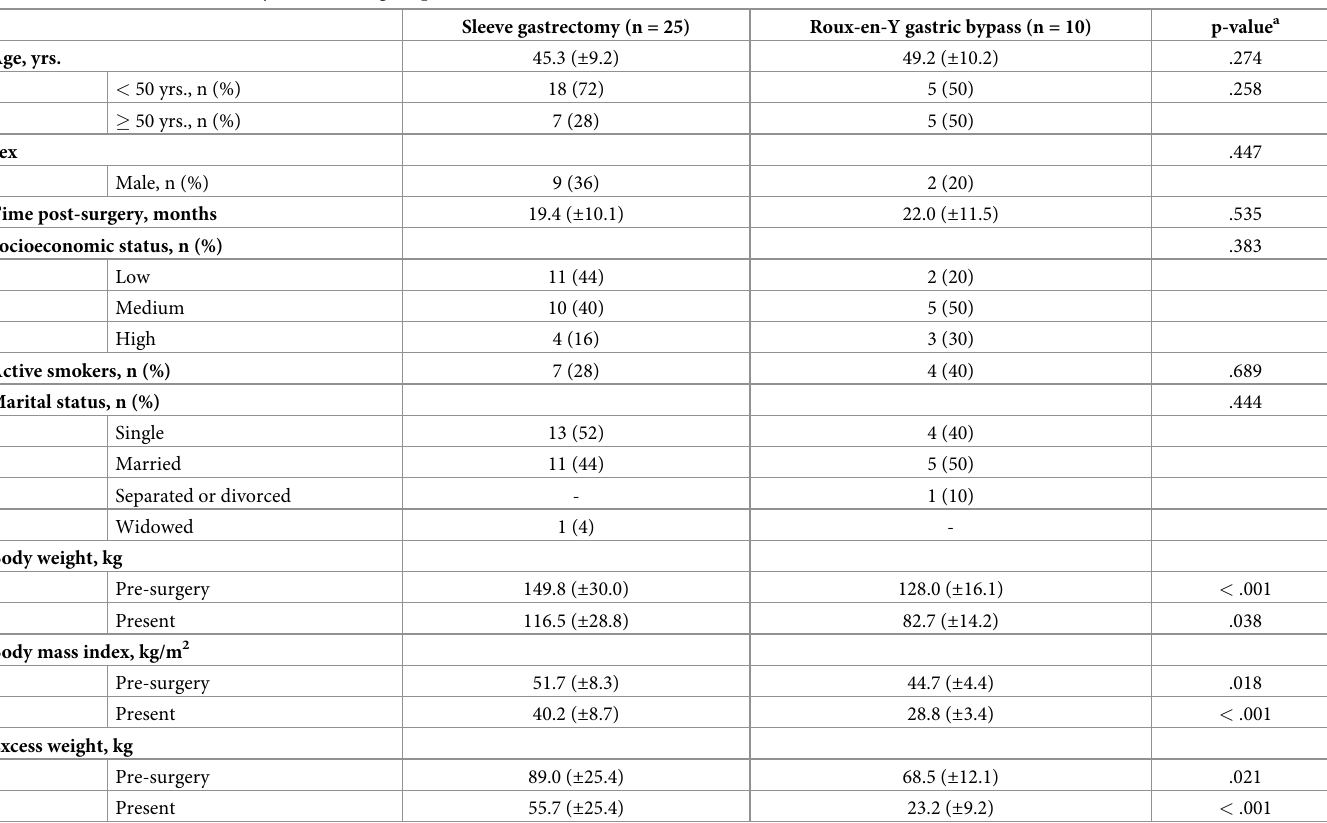
Table 1. Patient characteristics by bariatric surgical